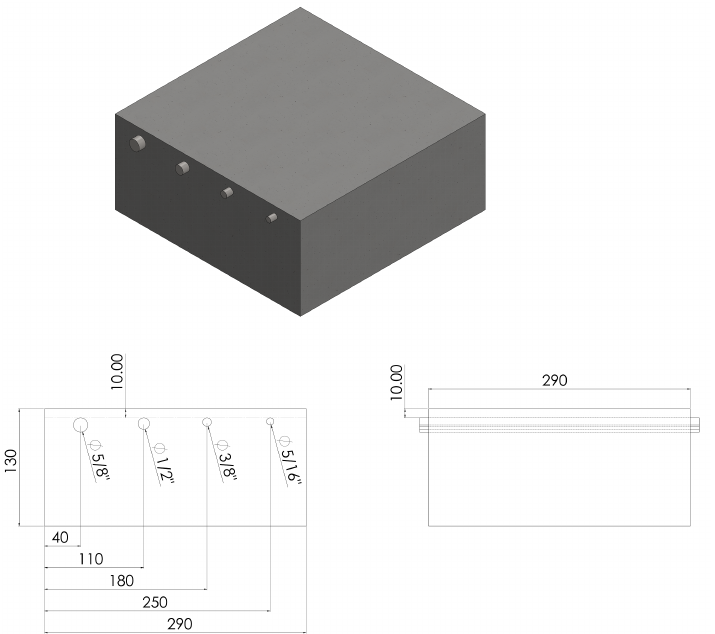
Figure 9. Schematic diagram of a concrete sample with rebars. The diameter of the rebars is 5/8, 4/8, 3/8 and 5/16 inches from left to right, respectively. They are placed at a distance of 10 mm below the concrete